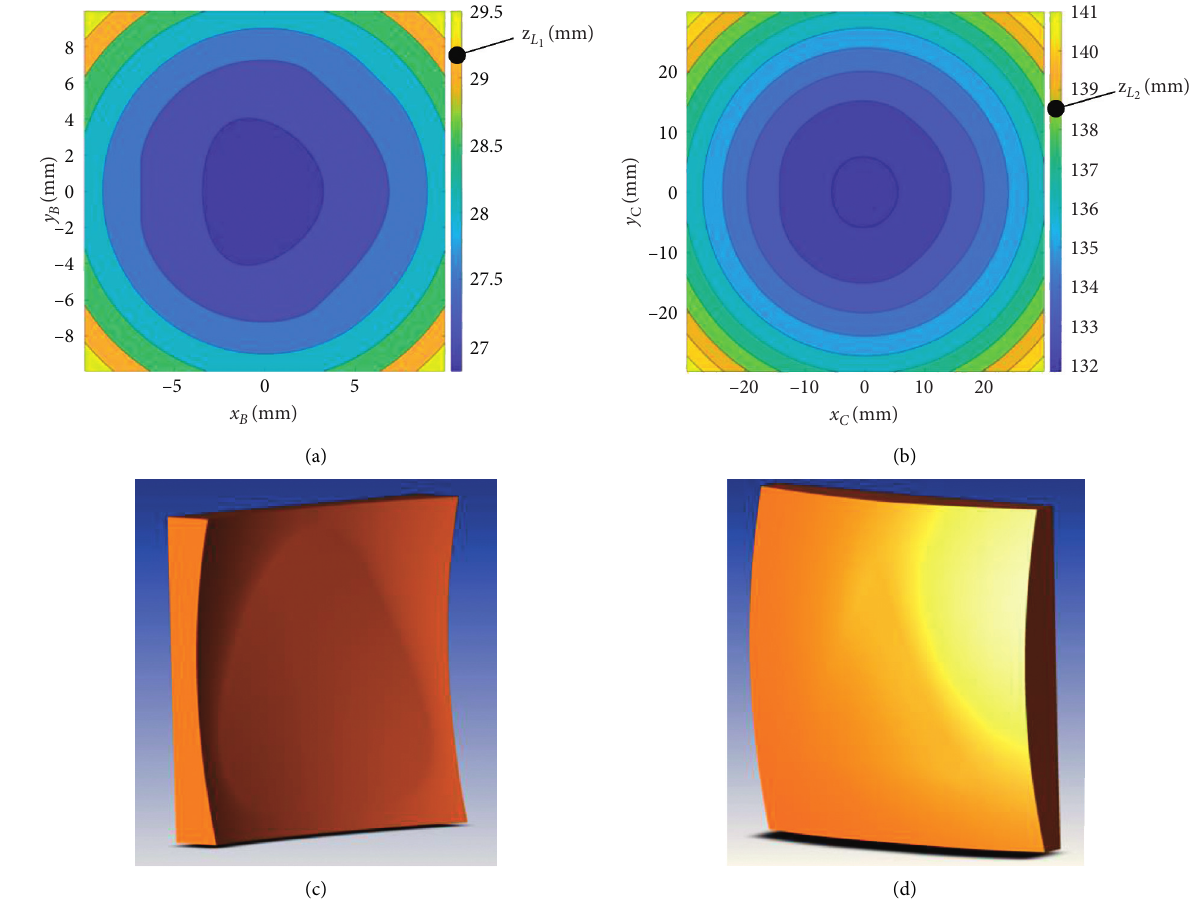
Figure 3: Contour plots (up) and CAD renders (down) showing the calculated freeform surfaces sag data: z